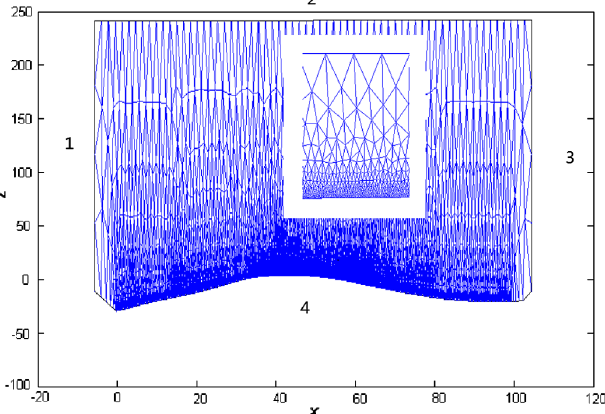
FIG. 12. Electromagnetic calculation model for electropolished Nb surface. Note: The axis ratio is set as 3 ∶ 1 to show in a distinguishable format. The inset is an enlargement where the axis ratio is 1 ∶ 1 . Unit: μ m.